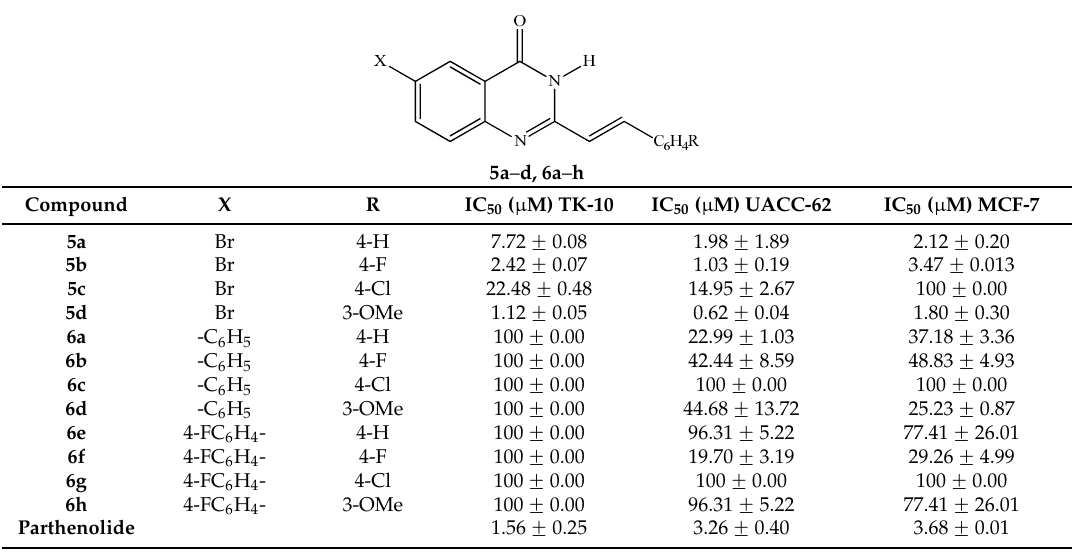
Table 1. IC 50 values of the test compounds against the three cancer cell lines.